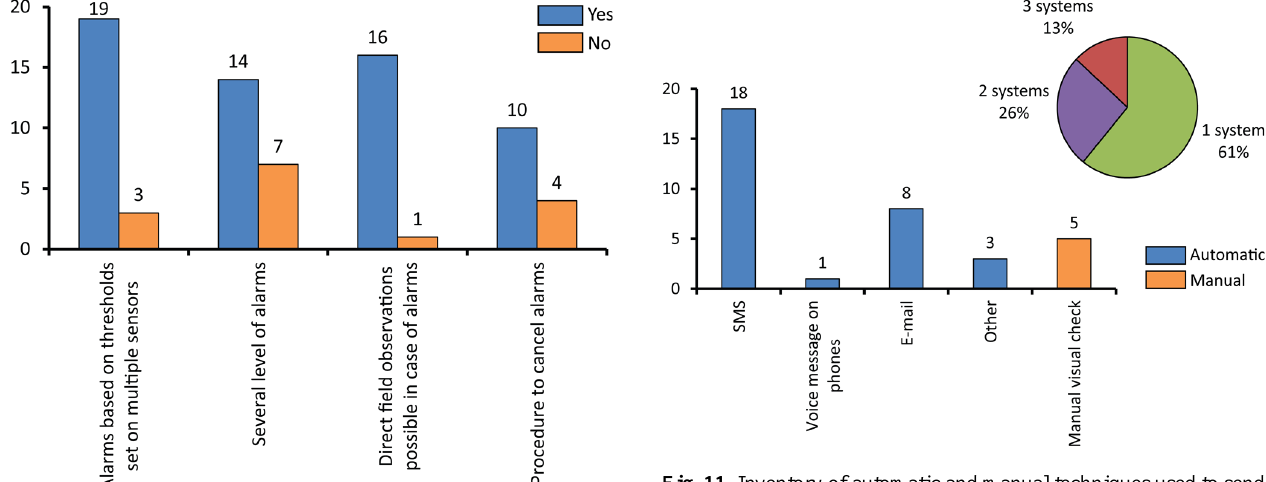
Fig. 11. Inventory of automatic and manual techniques used to send alarms from the monitoring network to the operational unit and per- centage of number of techniques used simultaneously for the 23 reported monitoring networks. The total number is above 23, since 39% of the monitoring networks use more than one